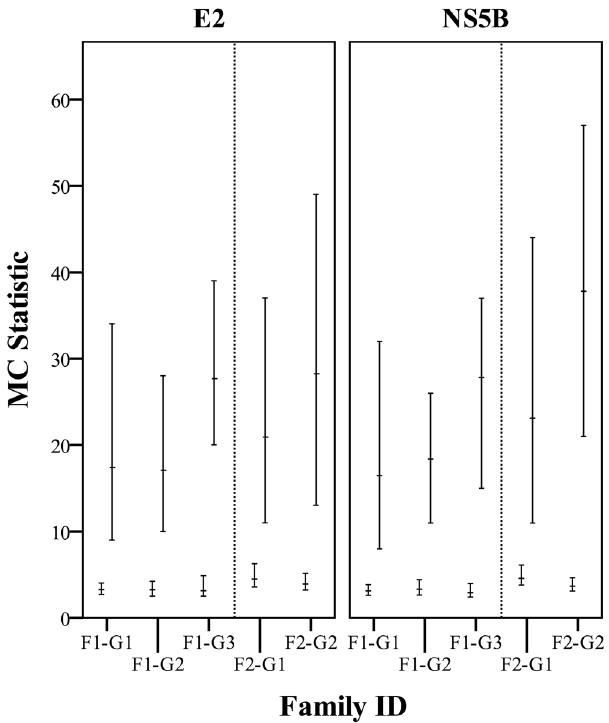
Fig 6. MC test and null distributions calculated with Befi-BaTS for each member of the PI families. Mean MC values are indicated by horizontal bars with the 95% confidence intervals of the null (lower bars) and test (upper bars) distributions indicated by the bars. All differences between null and test distributions are statistically significant as indicated by non-overlapping confidence